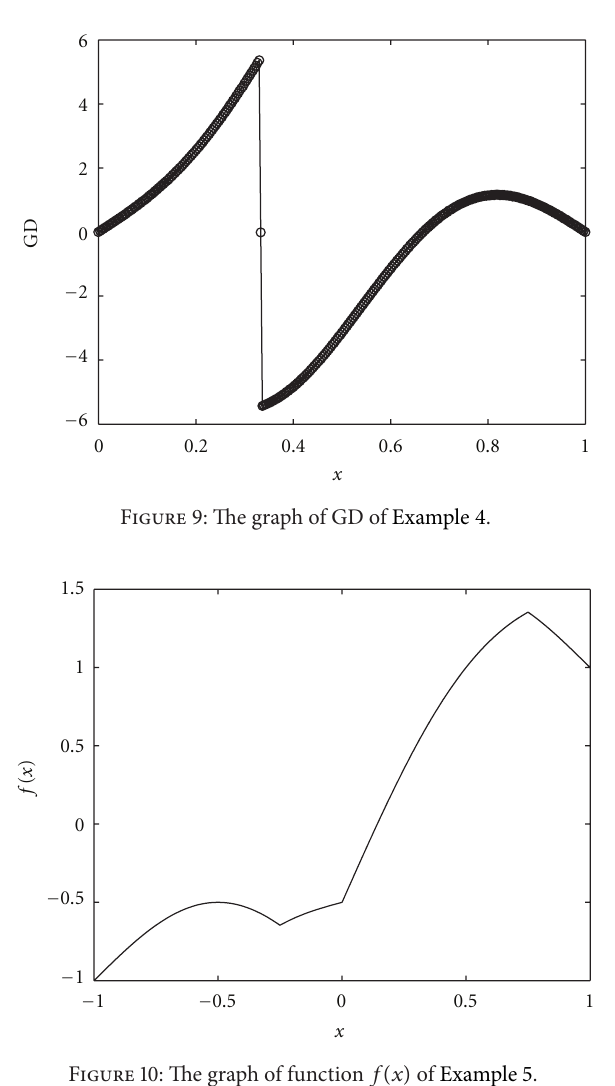
Figure 10: The graph of function 𝑓(𝑥) of Example 5. Table 2: Numerical results of Example 3. 𝑁 Approximate optimal solution Approximate optimal value